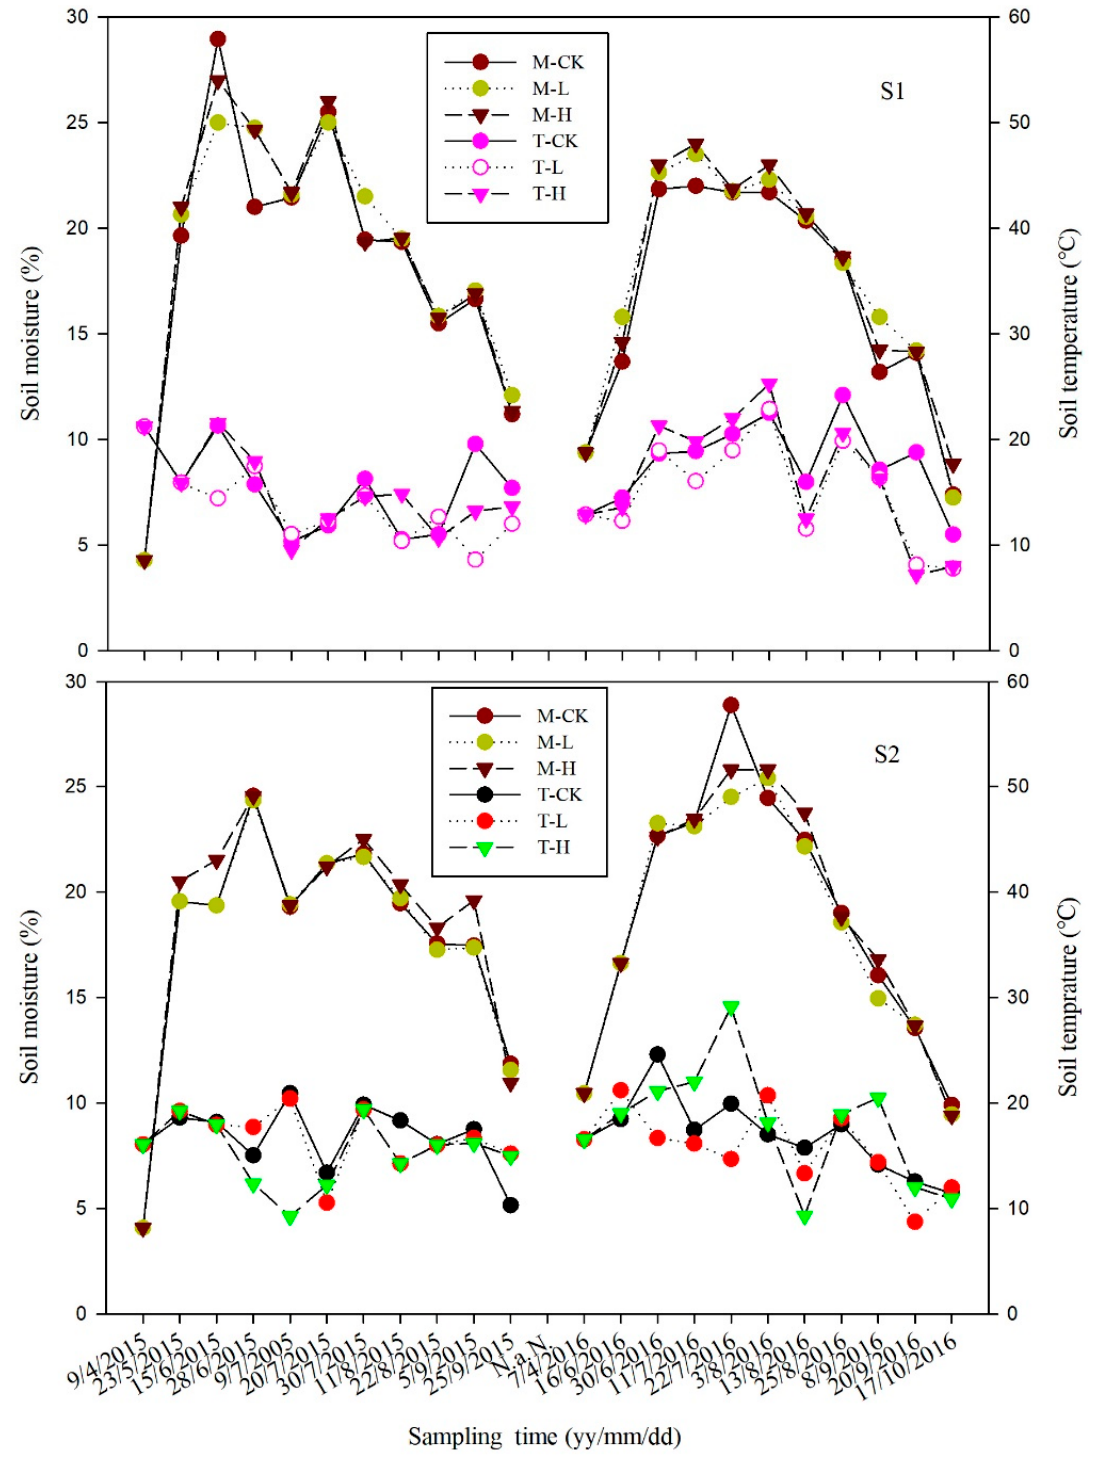
Figure 2. Variation pattern of soil moisture and soil temperature in the S 1 and S 2 with three levels of nitrogen fertilization (H, L, and CK) in saline soil from 2015 to 2016. (S 1 : slightly saline soil; S 2 : strongly saline soil; M: soil moisture; T: soil temperature).